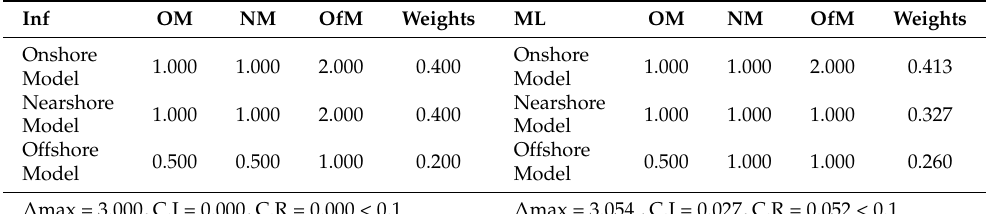
Table 10. Weights of the alternatives with respect to the infrastructure and maturity level. Inf